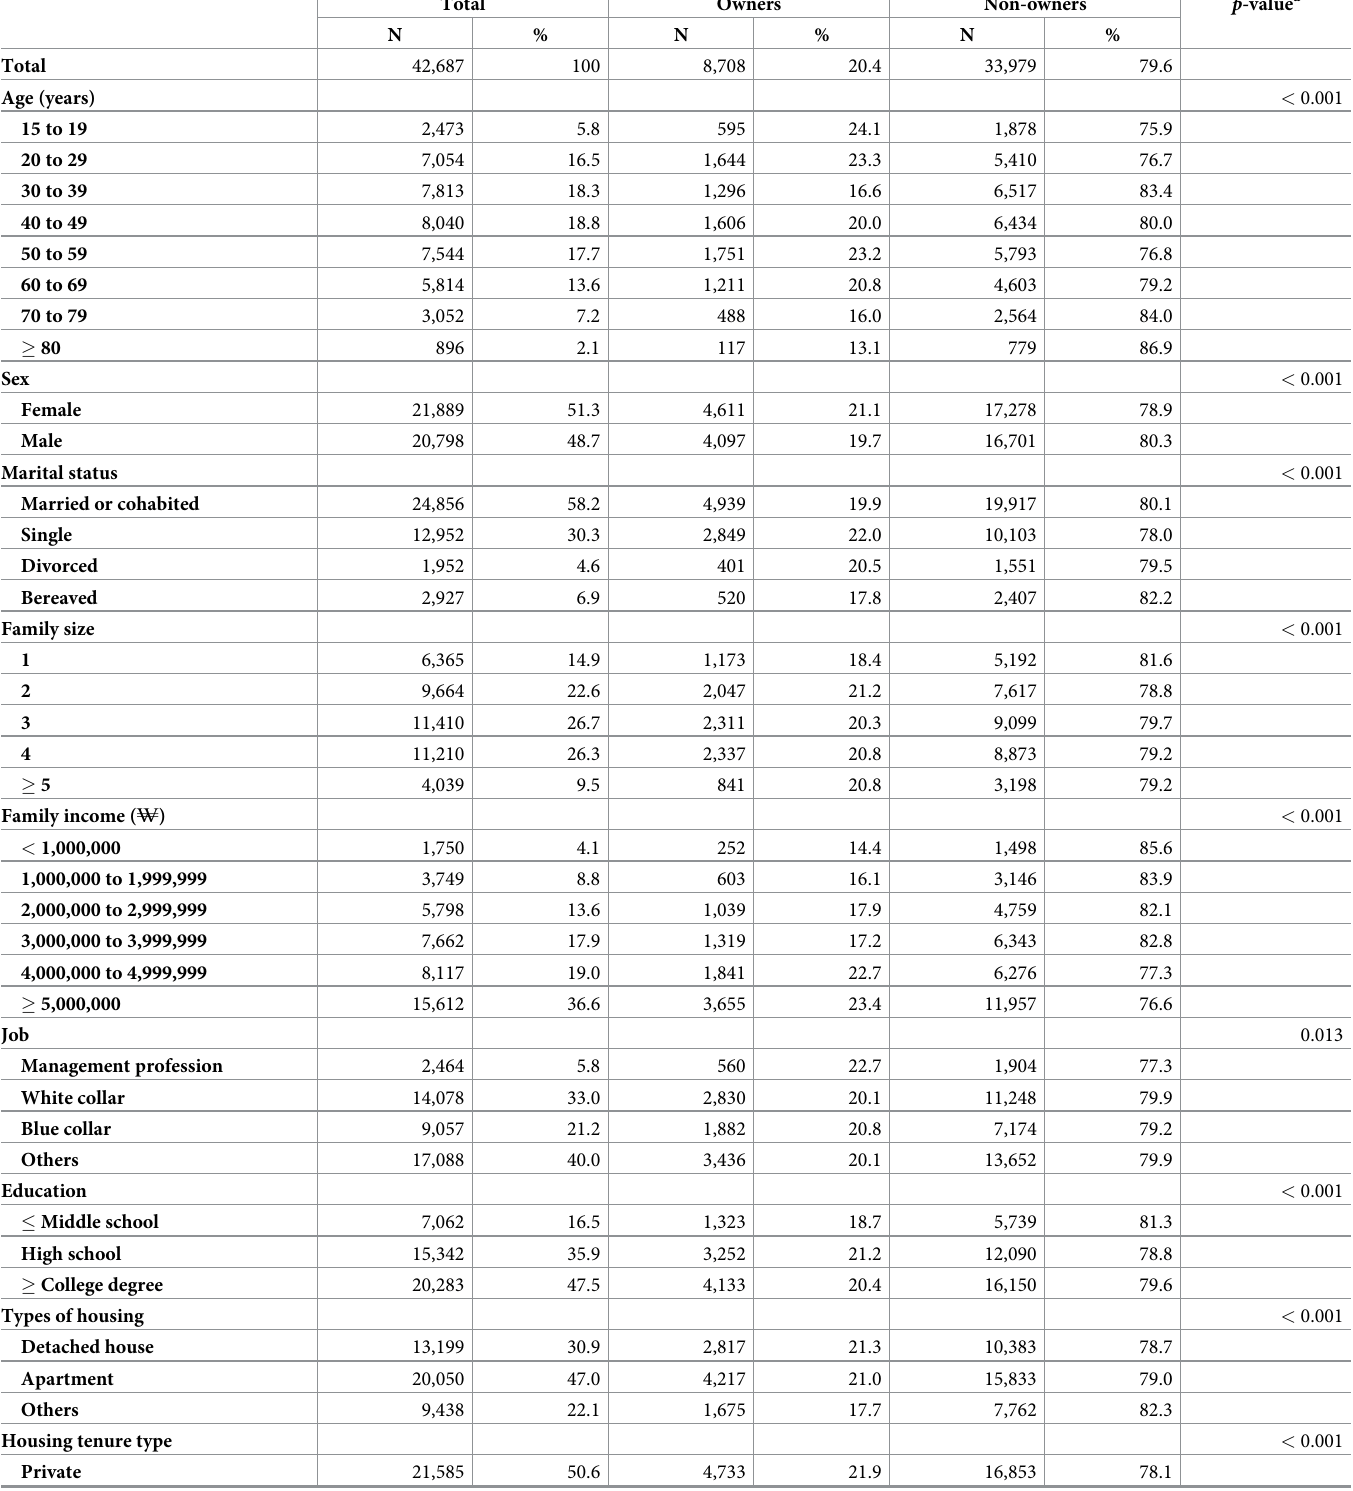
Table 1. Demographic characteristics of participants by pet